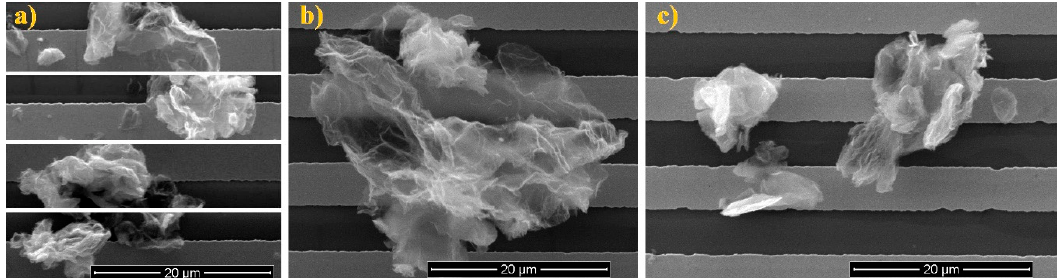
Figure 4. SEM images of graphene oxide: ( a ) Sample 1 (different areas), ( b ) Sample 2 (cloud type structure) and ( c ) Sample 2 (compact type structure).